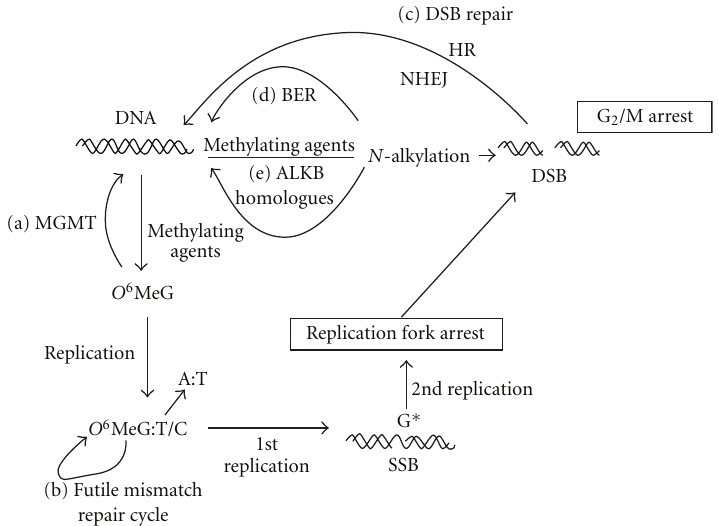
Figure 1: Pathways for DNA damage induced by methylating agents. (a) O 6 -methylguanine-DNA methyltransferase (MGMT) removes the methyl adduct from O 6 MeG in one step. If left unrepaired, O 6 MeG:C ambiguous pairs or O 6 MeG:T mismatch pairs can form during replication. In the next round of replication, O 6 MeG:T pairs can become A:T transition mutations. (b) O 6 MeG:T and O 6 MeG:C pairs are recognized by the mismatch repair (MMR) system, which creates a single-strand break (SSB), cause replication arrest, and finally leads to a double-strand break (DSB). O 6 MeG:T/C does not induce cell cycle arrest at the first G 2 /M DNA damage checkpoint, but G 2 /M arrest is commonly observed in the second cell cycle. (c) Homologous recombination (HR) and nonhomologous end joining (NHEJ) may play a role in the repair of DSBs. N -alkylations are repaired by either (d) base excision repair (BER), or (e) AlkB homologues, and if not repaired, DSBs